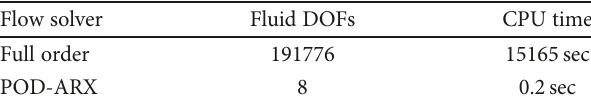
Table 1: Computational e ffi